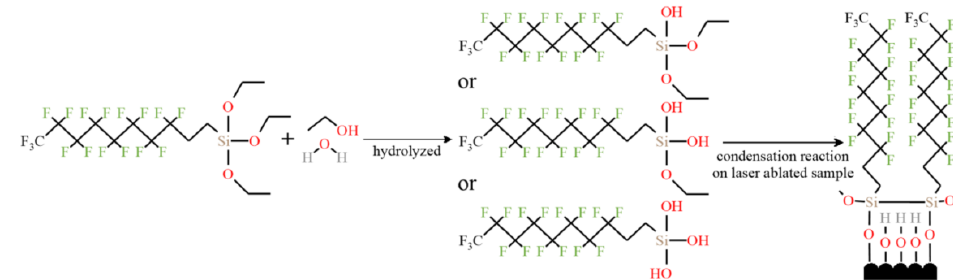
Figure 24. Microscopic reaction of forming superhydrophobic film by self-assembly on a brass surface (Reprinted with permission from Ref. [47]. 2021, Zhang, L.).